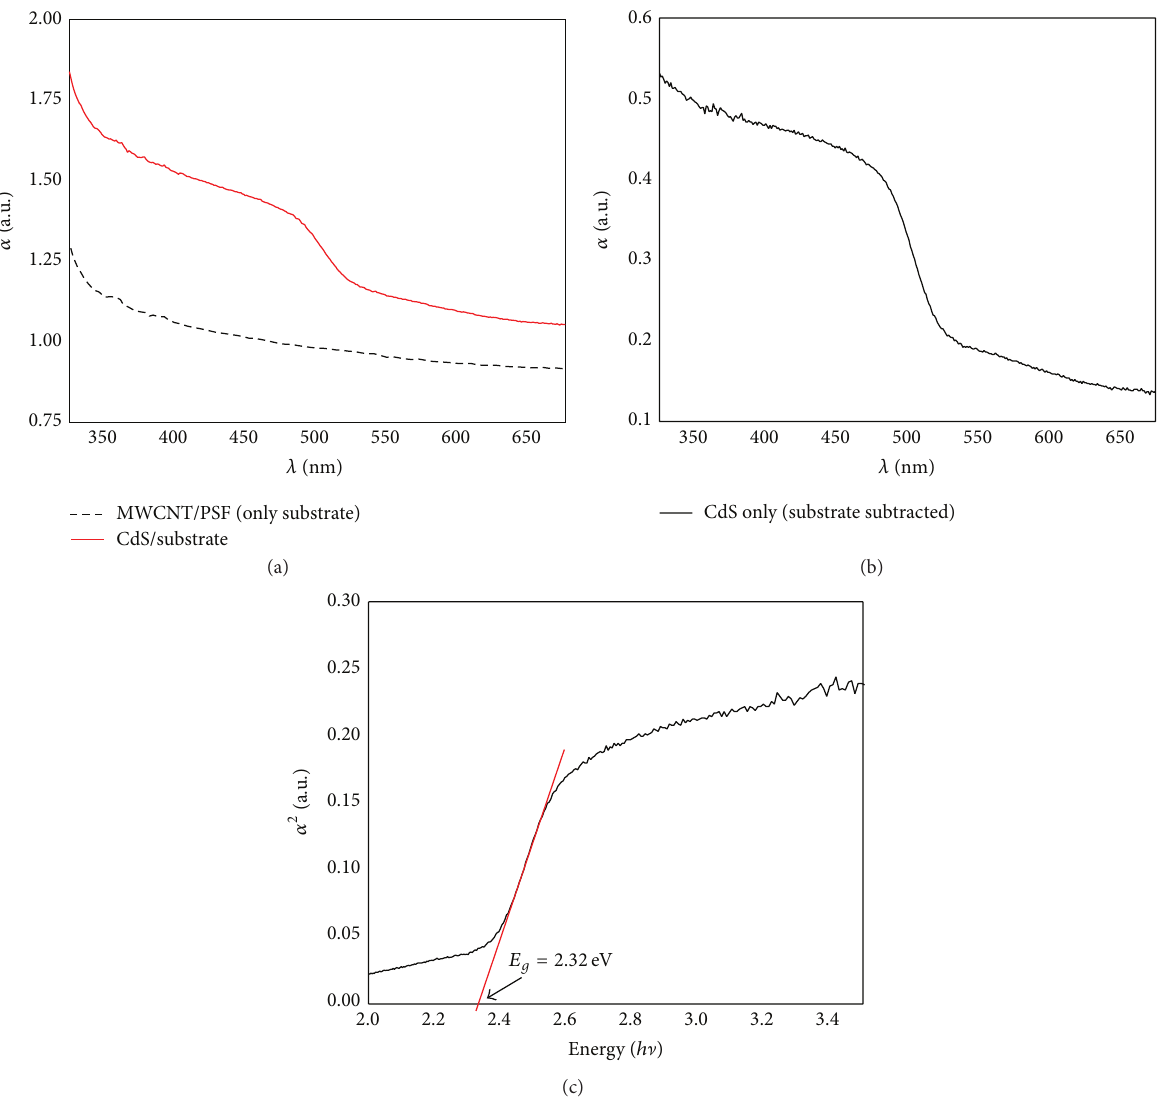
Figure 3: Optical characterization of a representative CdS thin film deposited by CBD. (a) Absorbance spectra of the MWCNT/PSF substrate (dashed line) and of the CdS/substrate system (solid line) as a function of the wavelength, (b) absorbance spectrum of the CdS/film obtained by subtracting the reference spectrum (substrate), and (c) 𝛼 2 versus energy ( ℎ ] ) plot obtained from data of Figure 3(b). The straight line in the linear portion of the plot is included for clarification